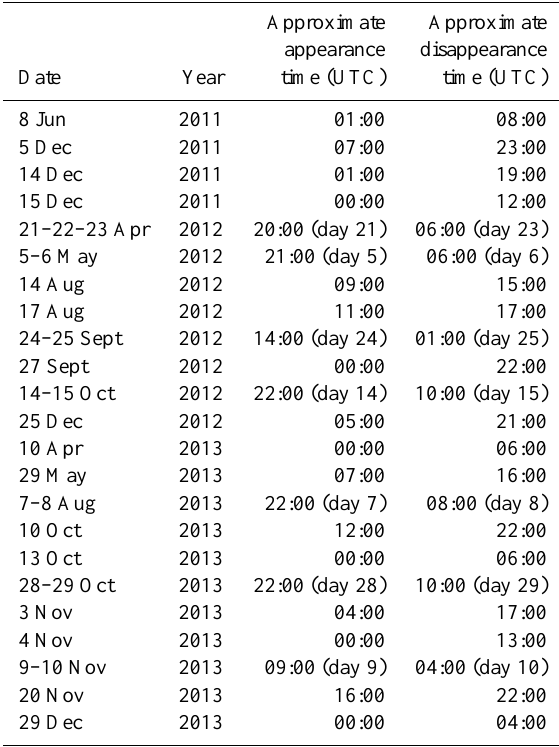
Table 1. Instances of linear-cloud formations that occurred over Italy during 2010–2013. Approximate Approximate appearance